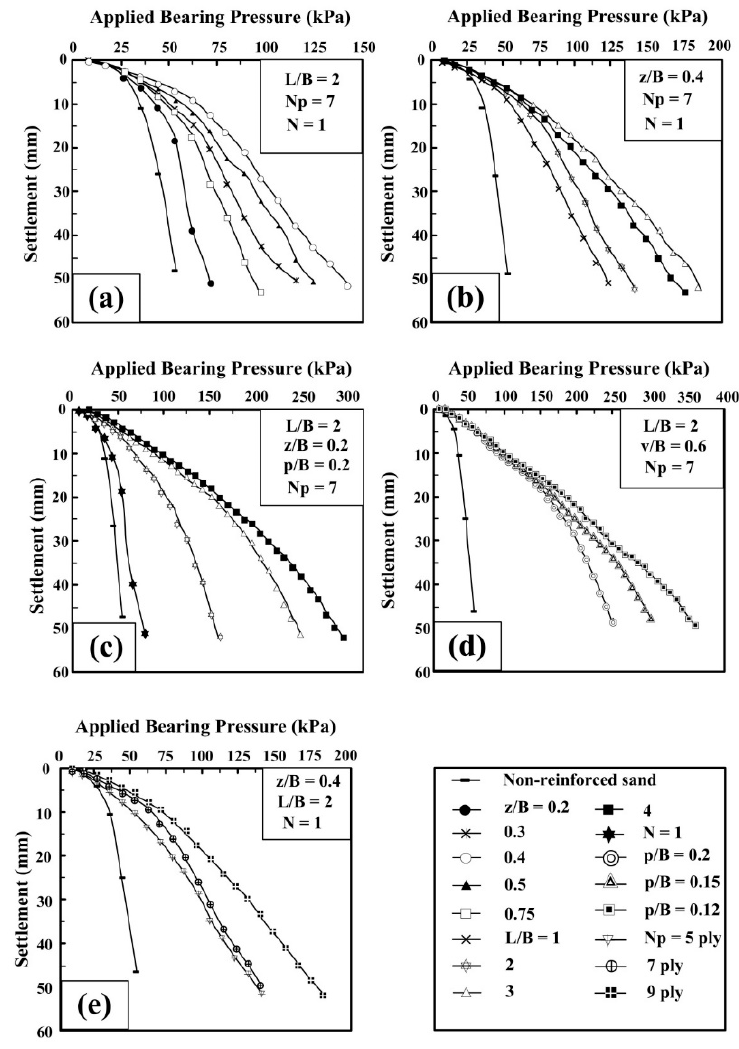
Figure 4. Bearing pressure against footing settlement curve for different: ( a ) reinforcement embedment depth, ( b ) the lengths of the reinforcement, ( c ) the number of layers of reinforcement, ( d ) the vertical spacing of the reinforcement, and ( e ) the number of plies of reinforcement (modified from Vinod et al. [39]).